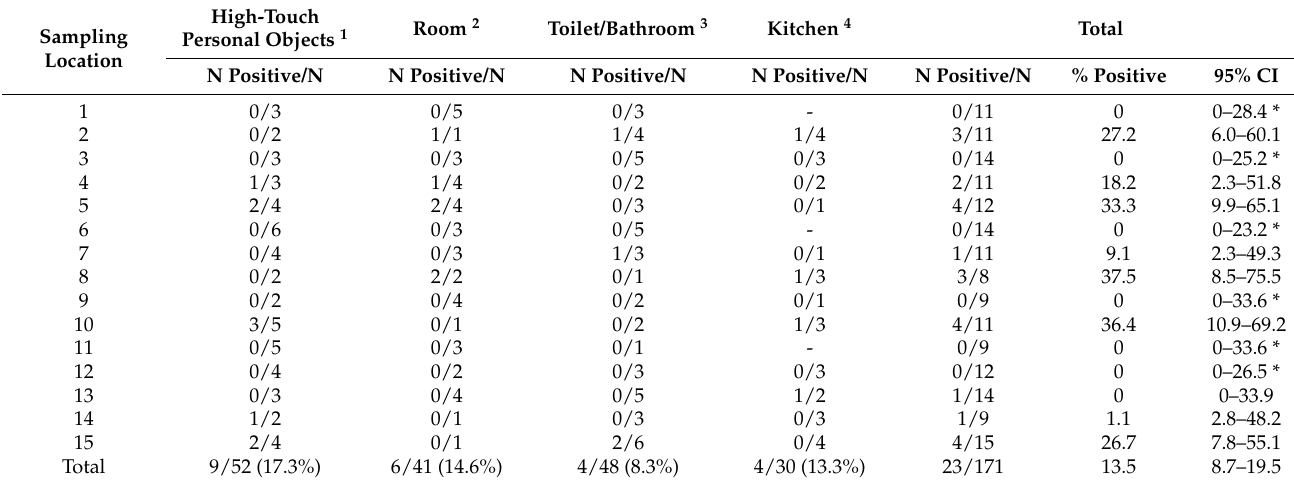
1 Telephone/cellular phone, keyboard, light switch, thermometer, TV remote, reading glasses, etc.; 2 Door handle, window handle, chair, pillow, etc.; 3 Light switch, toilet seat, faucet, toilet brush etc.; 4 Locker, fridge handle, light switch, fridge handle, etc.; CI = confidence intervals; * one-sided 97.5% CI.